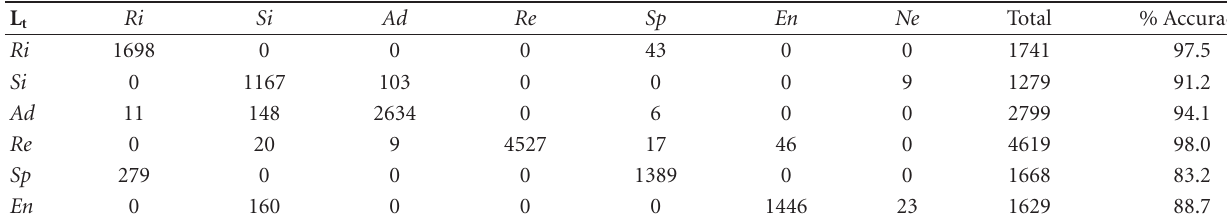
Table 6: Confusion